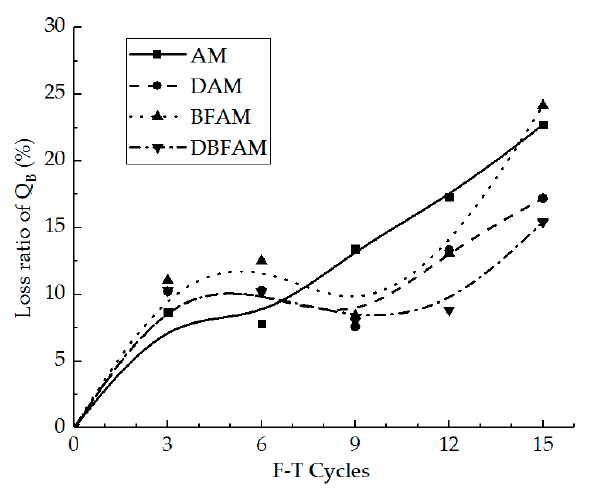
Figure 12. Loss ratio of deformation energy density under F–T cycles.